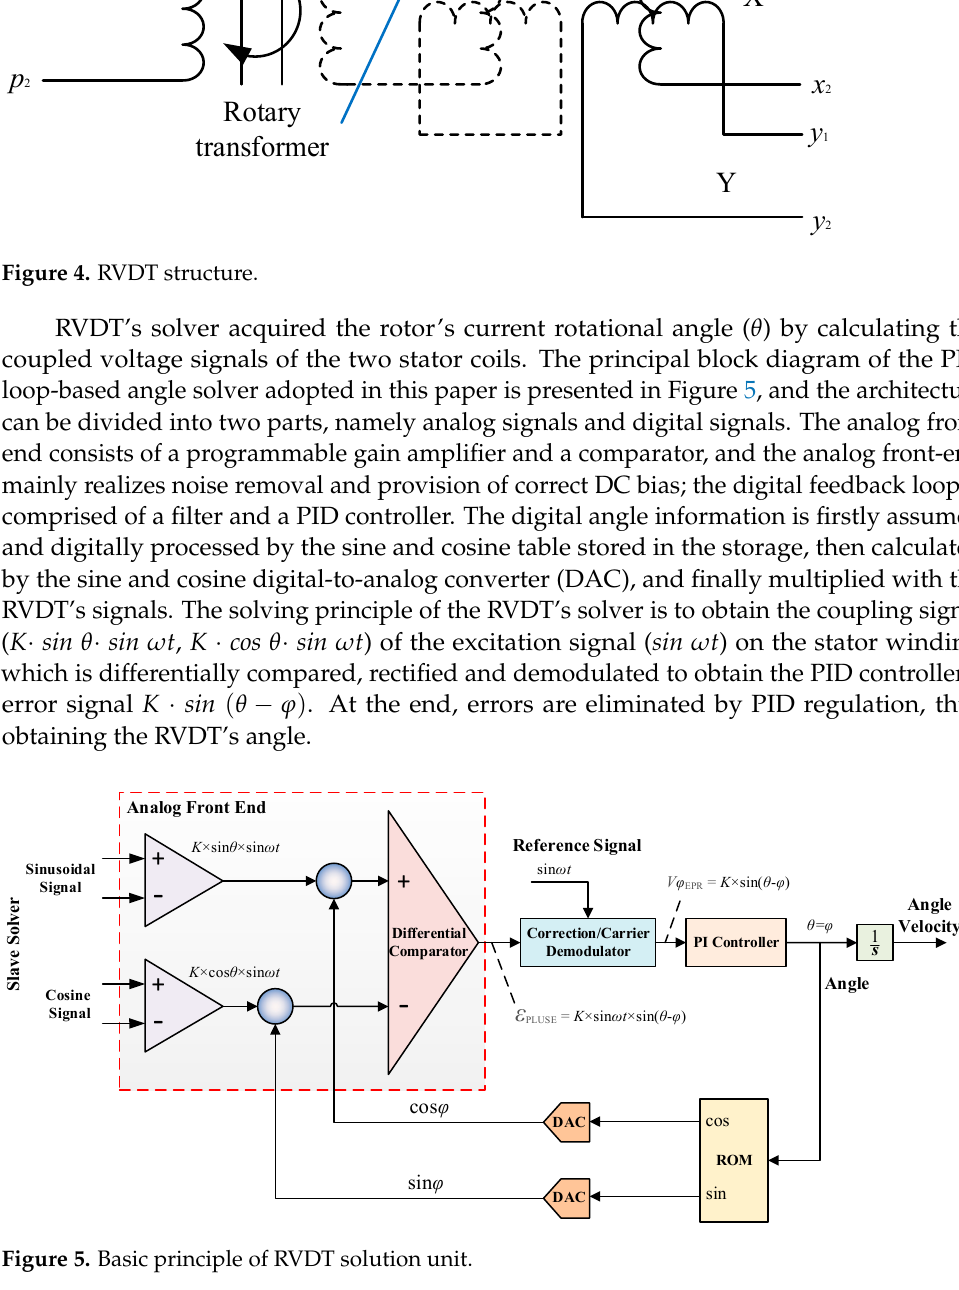
Q4 VCC Figure 6. Schematic diagram of “H-bridge”. 2.3.4. Load A LATM directly controls the metering valve angle by levers and gears to meter fuel. The valve components and the effect of fuel pressure on the motor’s rotating shaft can be equivalently regarded as a certain load disturbance. A motor’s load model is often estab- lished with an ideal torque source module + mathematical signal source or mechanical spring module + gear set module in the motor’s integrative component models. Therefore, the LATM integrative physical simulation model of fuel metering appa- ratus established according to the method is demonstrated in Figure 7.